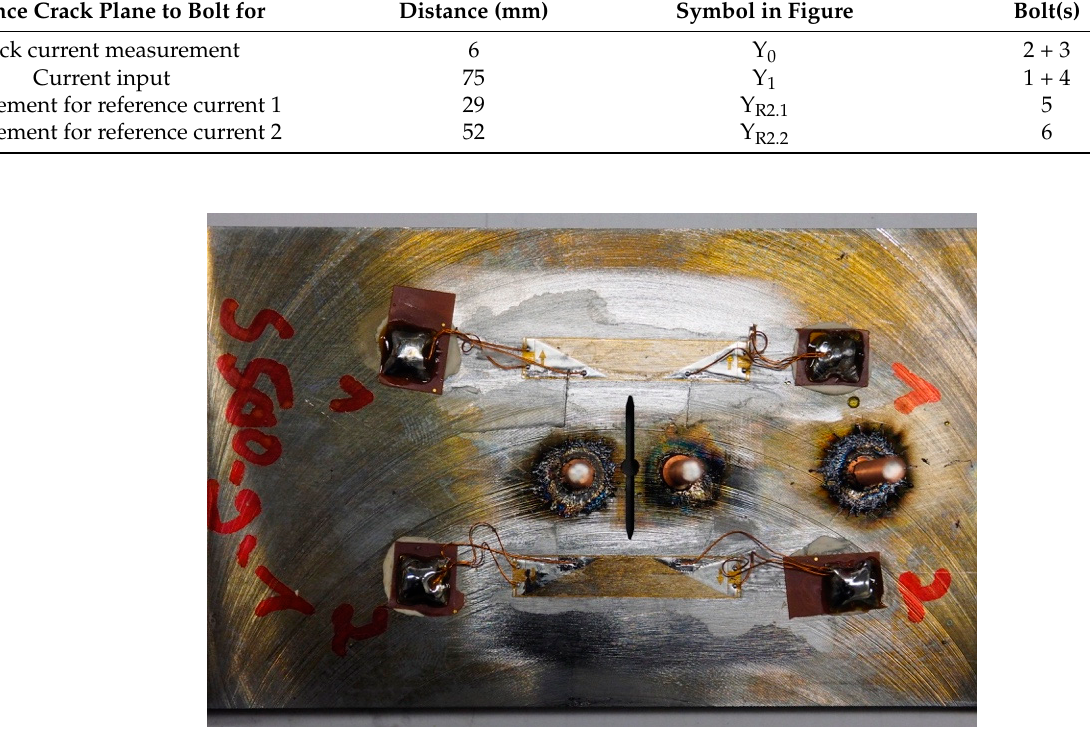
Figure 3. Photograph of one of the welded specimens with a machined surface, heat tint from the heat treatment, the two crack detection gauges, and the copper-coated bolts for current measure- ments.